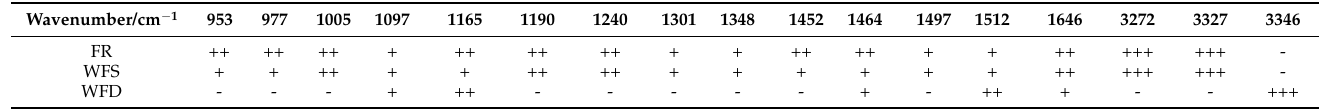
Table 4. Autopeaks and their intensities Φ for FR, WFS, and WFD in 2D-COS-IR